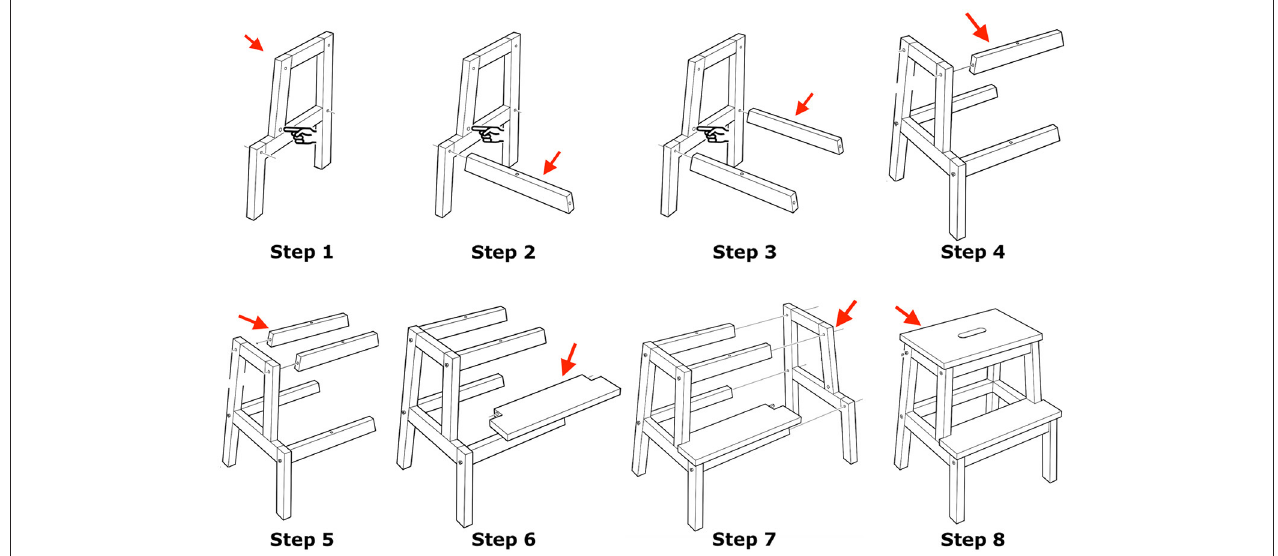
FIGURE 3 | Subjects were given visual instructions in steps without verbal descriptors. The task is taken from the assembly procedure for the Bekväm stool sold by IKEA, circa 2018. In the steps visualised, the stool is assembled incrementally and secured with wooden bolts to make the assembly faster. Images taken and adjusted from the IKEA instruction book (with